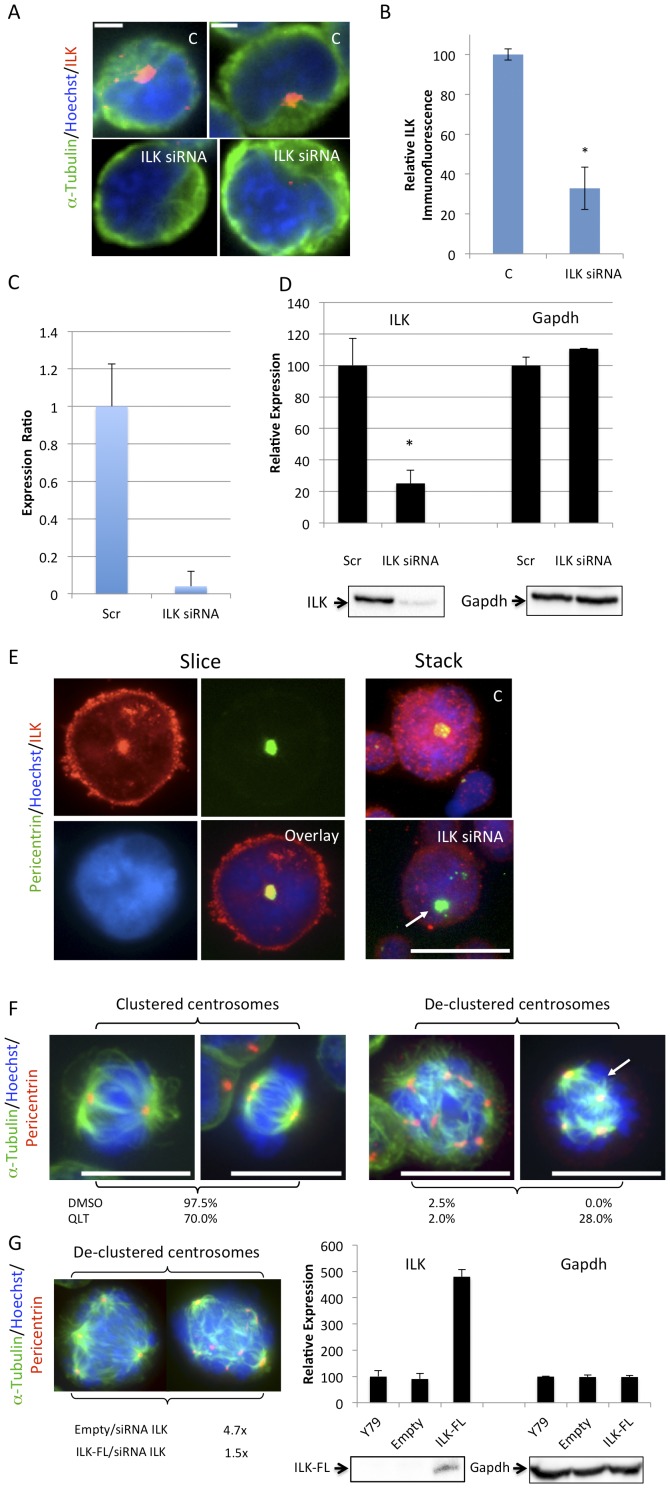
Loss of ILK Causes an Increase in Mitotic Cells Displaying Multipolar Division and De-clustered Centrosomes.(A) ILK immunofluorescence co-localized with α-tubulin at the centrosomes. Supernumerary centrosomes are typically clustered in one location of the cell when retinoblastoma cells are interphase. Y79 cells were treated with control (C) or ILK siRNA. A marked reduction of ILK centrosomal staining was observed when cells were exposed to ILK siRNA as compared to control siRNA. Shown are representative figures used in the analysis of relative centrosomal ILK immunofluorescence (see Figure 4B) where a predetermined threshold permitted only the brightest of pixels to be visible in a given field of view. Scale bar, 4 µm. (B) Staining of ILK at the centrosomes was estimated by comparing the fluorescence intensity profile of ILK at the centrosomes using Metamorph imaging software. For this analysis, a threshold was determined, allowing only the brightest of pixels to be visible in a given field of view in the control siRNA. Histograms indicate the relative intensity of ILK immunofluorescence at the centrosomes following treatment with control (C) or ILK siRNA. Data represent 3 separate trials calculated for a minimum of 500 cells/trial, p<0.05. (C) Integrin-linked kinase (ILK) knockdown using small interfering RNA (siRNA) in Y79 cells. Y79 cells were transfected with either a targeted oligo for ILK or a non-specific, scrambled control. After two, consecutive transfections, the total RNA was extracted and the cDNA was used for quantitative PCR analysis. Samples were run in triplicate from three separate trials, and the results were corrected for the β-actin data run each time. Bar graph depicts ILK RNA expression levels of ILK siRNA treated cells (ILK siRNA) relative to scrambled control siRNA (Scr) in a representative trial, run in triplicate. Data represent the average ± SD. (D) Western blots of Y79 cell lysates following treatment with ILK siRNA or scrambled control (Scr) was performed. Blots were probed first with a mouse anti-ILK antibody then stripped and reprobed with a rabbit anti-Gapdh antibody. Bar graph represents densitometric analysis of blots probed for ILK and Gapdh. Protein expression for ILK and Gapdh from 3 independent trials were averaged and normalized to the scrambled control. Data are mean ± SEM. * p<0.05 as determined by Student's t-test. Representative Western blots of ILK and Gapdh are also shown below each bar graph. (E) (Left “Slice”) Y79 cells were costained for ILK together with pericentrin and Hoechst. An overlay of these individual stains shows clear colocalization of ILK with pericentrin at the centrosomes. (Right “Stack”) Y79 cells treated with C or ILK siRNA that were subsequently costained for ILK and pericentrin. Flattened stacks showed a marked reduction of ILK centrosomal staining. Control (C) and ILK siRNA treated sister cultures are shown and are representative of three independent experiments. ILK staining has been reduced at the centrosome labeled with a white arrow in ILK siRNA treated cells. (F) Y79 cells were treated with 10 µM QLT-0267 for 5 days and then fixed and stained for α-tubulin and pericentrin. Cells with multipolar spindles in the DMSO treated group displayed highly disorganized α-tubulin staining and had large numbers of spindles. Conversely, in the presence of the ILK inhibitor, prominent α-tubulin staining appeared only associated with spindles and multipolar spindles were arranged most often in a tetrahedral configuration. The spindle pole labeled with a white arrow projects away from the plane of the paper while the others run more parallel with it. Bar represents 30 µm. (G) Centrosome de-clustering was also measured in Y79 cells expressing FLAG-tag (labeled empty) or FLAG-ILK constructs (labeled ILK-FL) following knockdown of ILK with siRNA. This rescue experiment was performed to validate the ILK siRNA centrosome de-clustering effect. After transfection, FLAG expressing clones were selected for 10 days and then treated with ILK siRNA or scrambled control. De-clustered centrosomes were compared in mitotic cells following ILK siRNA treatment and results were normalized to scrambled control in each experimental group. De-clustering of centrosomes in mitotic cells expressing FLAG-tag and treated with ILK siRNA was 4.7x that seen in scrambled control while in cells expressing FLAG-ILK de-clustering was 1.5x that seen in scrambled control. Data represent three independent experiments in which ≥100 mitotic cells were sampled for each condition. Y79 cell extracts untransfected, or transfected with either FLAG-tag or FLAG-ILK were analyzed by Western blotting. Blots were probed first with a mouse anti-FLAG antibody and subsequently reprobed with a rabbit anti-Gapdh antibody. Western blots of FLAG-ILK (labeled ILK-FL) and Gapdh are shown. Bar graph represents samples, run in quadruplicate. Data are expressed as the average ± SEM.